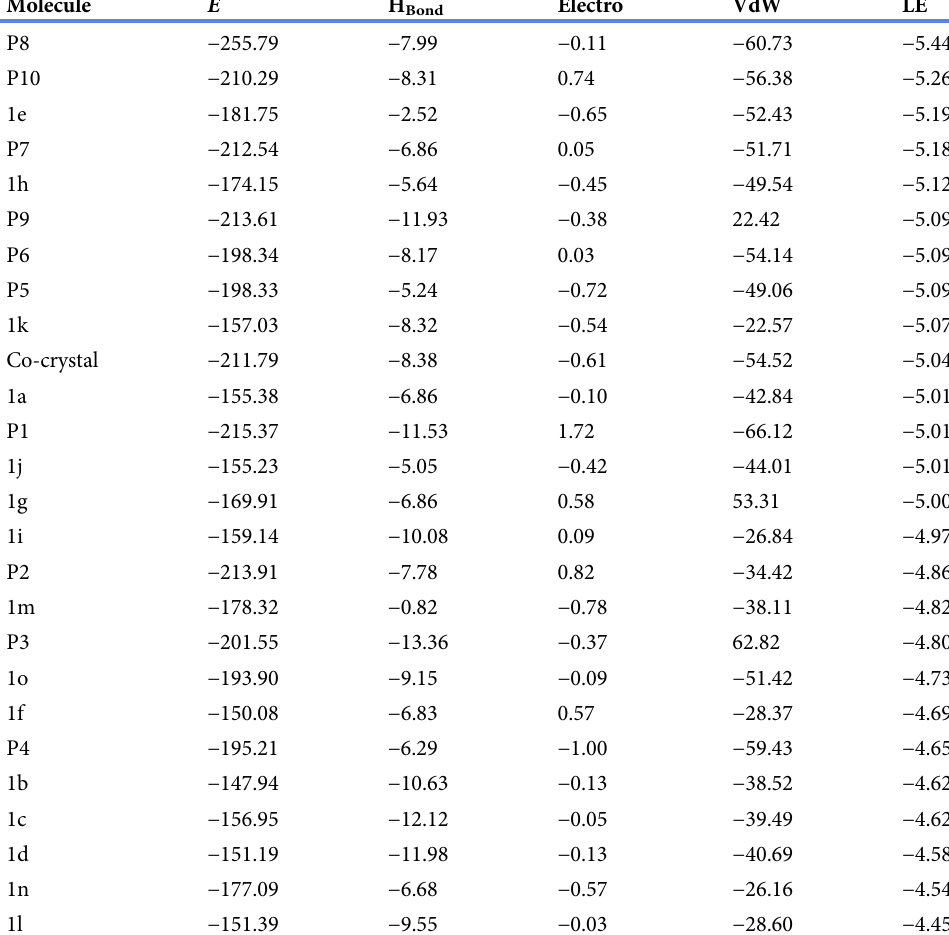
Table 1 Interaction energies between the modeled ligands and the protein CoV-2-M Pro . All the units are represented in kcal/mol. H Bond means the hydrogen bond interactions, Elstat the electrostatic energies, VdW indicates the Van der Waals energy and, LE is the ligand ef fi ciency (LE = E /No heavy